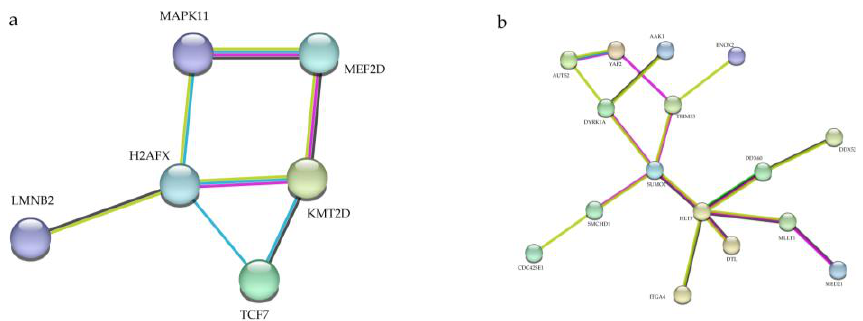
Figure 5. Protein – protein interaction networks of tRF-58:74-Gly-GCC-1 and tiRNA-1:35-Leu-CAG- 1-M2. ( a ) The protein – protein interaction network of corresponding target genes oftRF-58:74-Gly- GCC-1 and ( b )